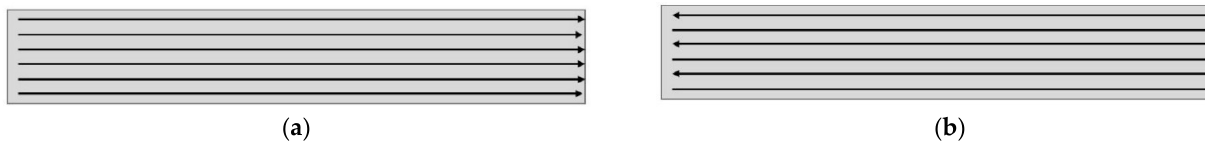
Figure 8. Illustration of the scan strategy at the same layer ( a ) unidirectional scan; ( b ) bidirectional scan.